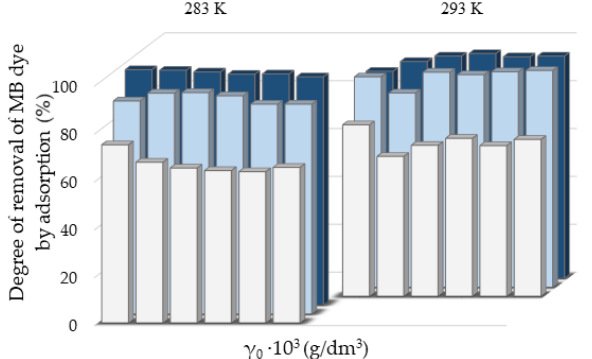
Figure 7. Removal degree of RB dye by adsorption on ■ NaY, ■ NH 4 ZSM-5 and ■ NH 4 BETA zeolites at two temperatures, calculated after 180 min.